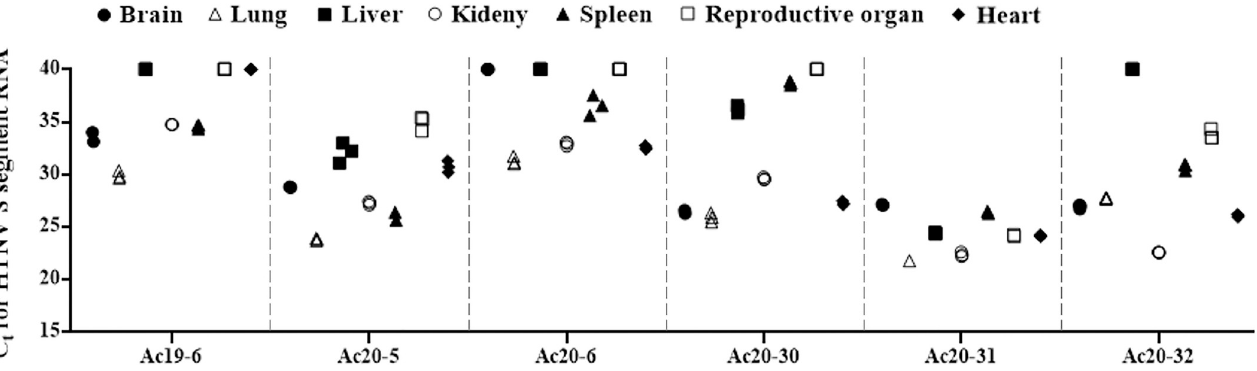
Fig 2. Measurement of HTNV RNA loads in different tissues of Apodemus chejuensis , Jeju Island during 2018–2020. Ct values were determined for HTNV RNA of the S segment in brain, lung, liver, kidney, spleen, reproductive organ, and heart tissues obtained from six rodents positive for HTNV IgG and HTNV RNA. Ct, cycle threshold; S, small; HTNV, Hantaan virus; IgG, immunoglobulin G.